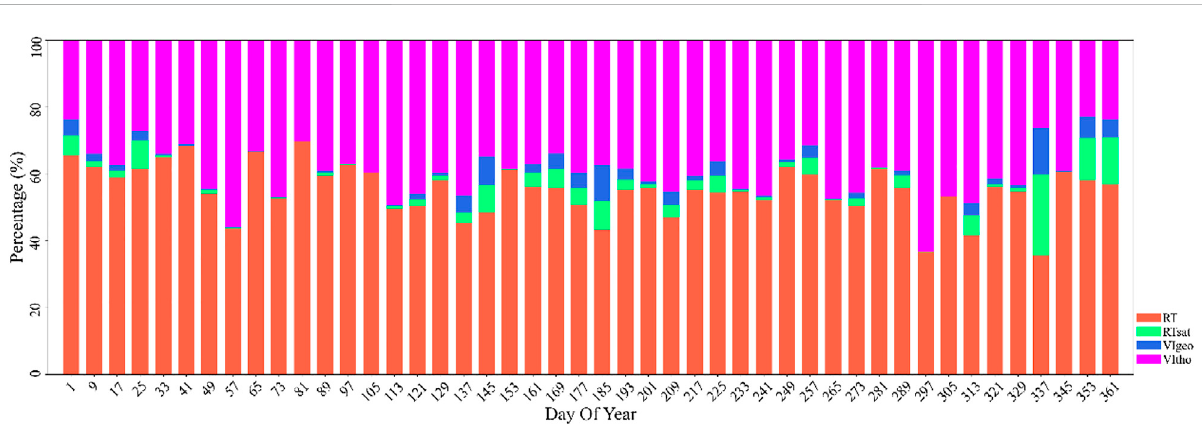
FIGURE 7 Temporal variation of MODIS LAI quality control fl ags (QC) over h27v05. DOY: day of the year; RT: main radiative transfer (RT) method used; RTsat:mainradiativetransfermethodwithsaturation;VIgeoandVIoth:empiricalvegetationindex(VI)algorithmusedduetobadgeometryandother problems,